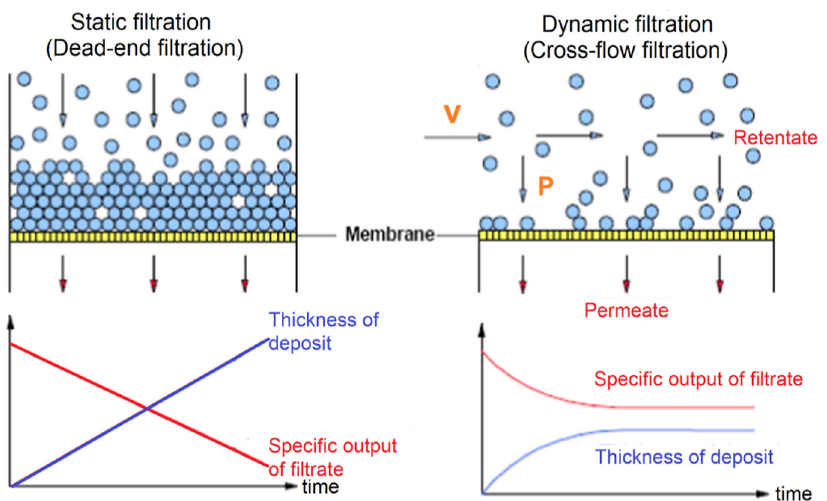
Figure 8. Membrane flow configurations and fouling formation [93].